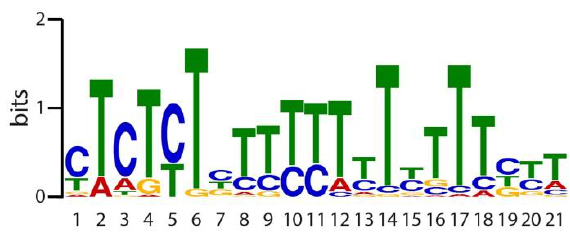
Figure 6. Position weight matrix representation of top-scoring 21-mers for the identified sequence motifs in the promoters of the seven investigated KT/KUP/HAK family transporter genes. The seven 1,000 bp spanning promoter regions contain a total of 34 sites of this motif. With an E -value of 1.5 × 10 −25 the motif was the most significant disclosed motif.